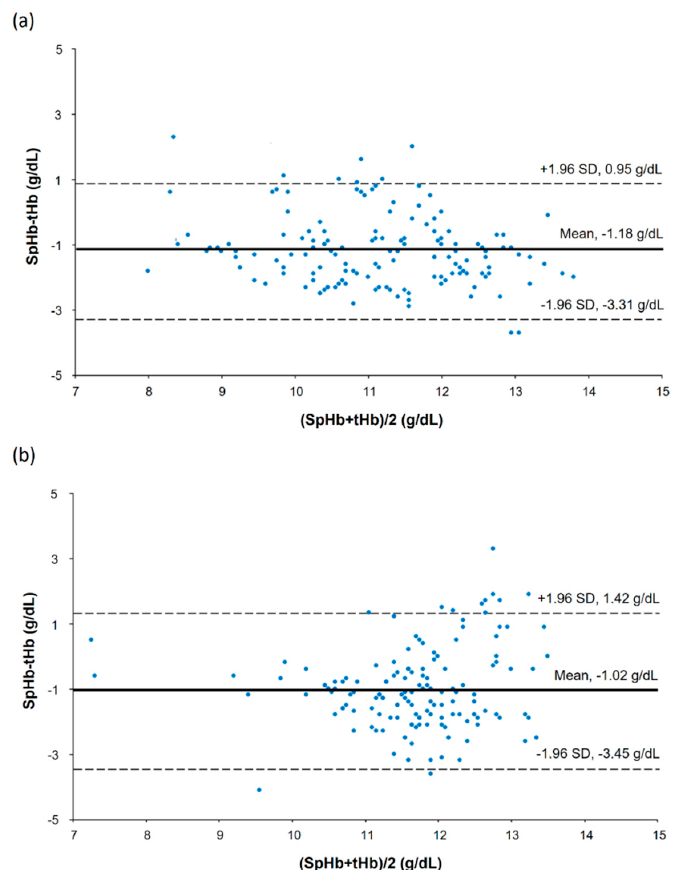
Figure 2. Scatter plot showing real-time continuous hemoglobin and laboratory hemoglobin data in the low carbon dioxide (CO 2 ) (blue) and high CO 2 groups (green).